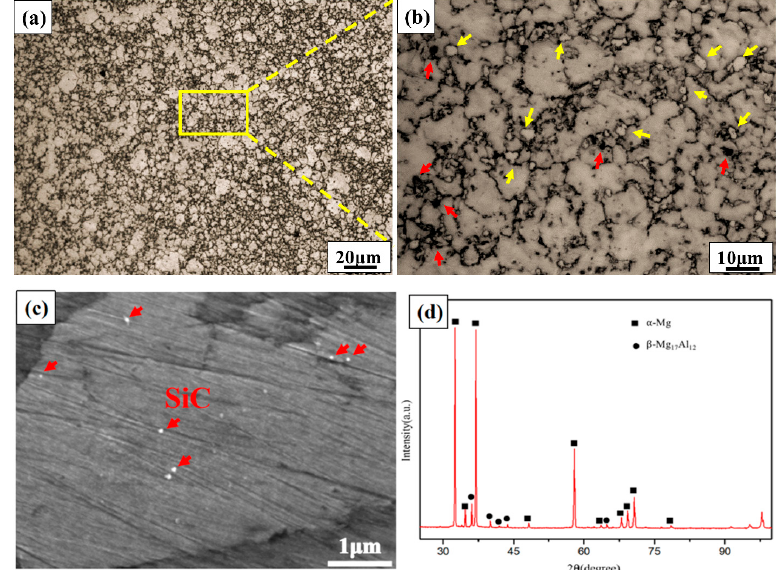
Figure 1. Microstructures of as-extruded nanohybrid/AZ80 composite vertical to extrusion direction: ( a ) OM image; ( b ) enlarged views of partial regions in ( a ); ( c ) nano-SiC particles; ( d ) XRD pattern.